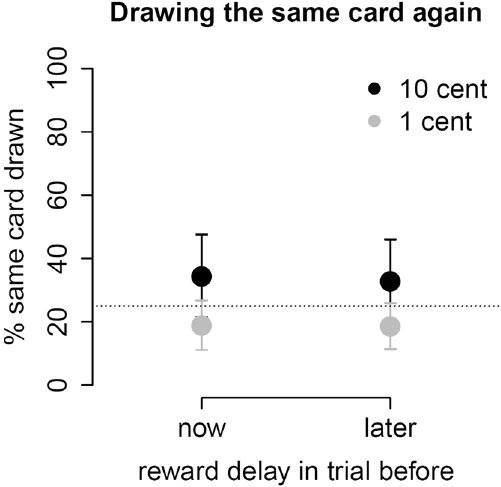
Figure 3. Participants more likely drew the same card again following large rewards, irrespective of the reward delay on the previous trial. The dotted line indicates chance probability (25%) for drawing the same card again. Error bars are 95% confidence